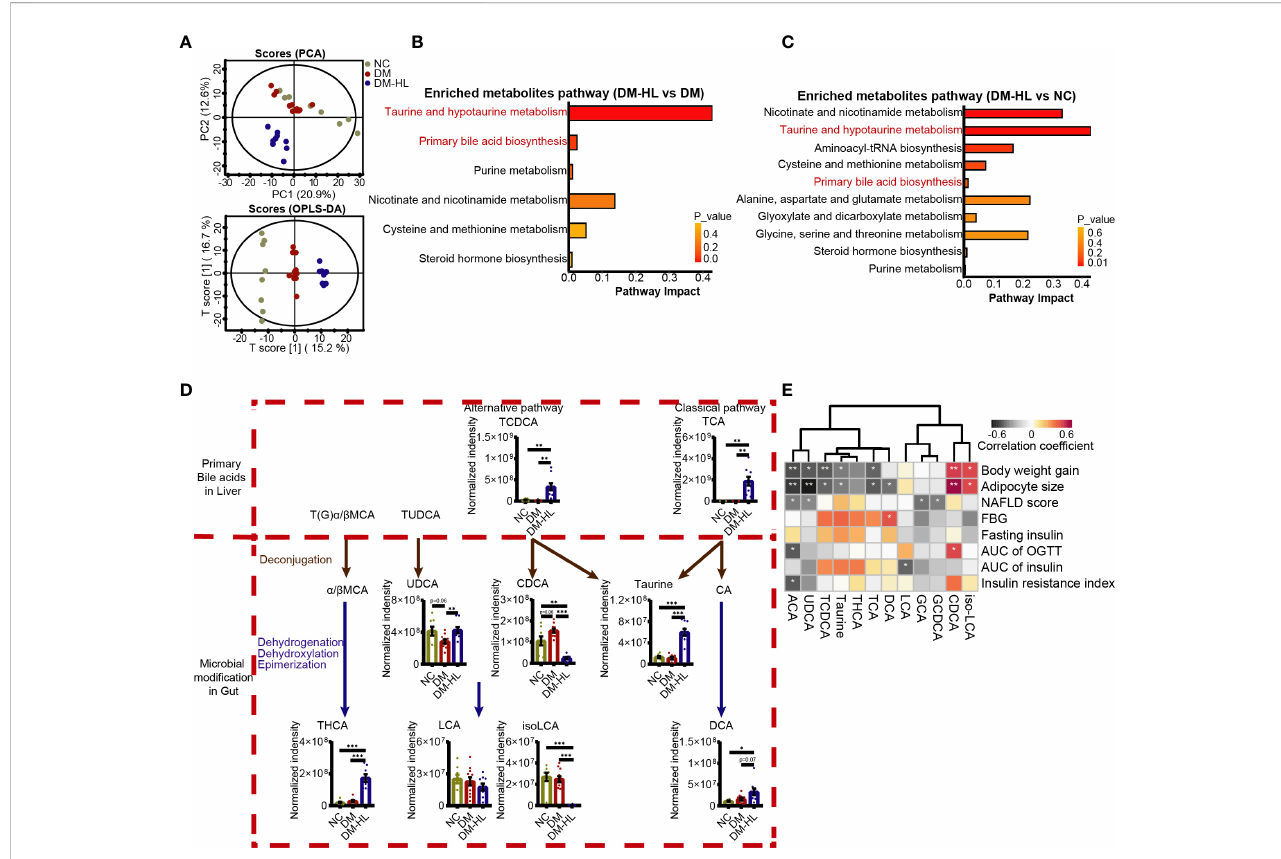
FIGURE 4 HL treatment altered the bile acid pro fi le in the colon. (A) Principal component analysis (PCA) and orthogonal projection to latent structure-discriminant analysis (OPLS-DA) plot of the metabolome across all samples. (B) Enriched metabolite pathway in the DM-HL group compared to the DM group based on metabolic enrichment pathway analysis. (C) Enriched metabolite pathway in the DM-HL group compared to the NC group. (D) Metabolites involved